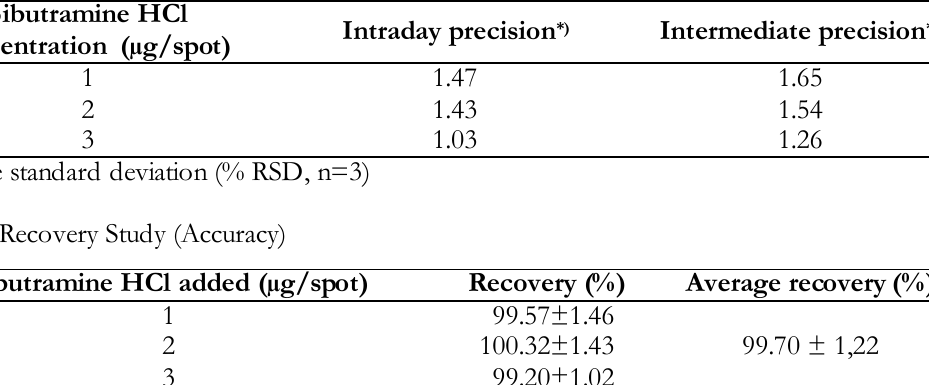
Tabel I. Intraday and intermediate precision study